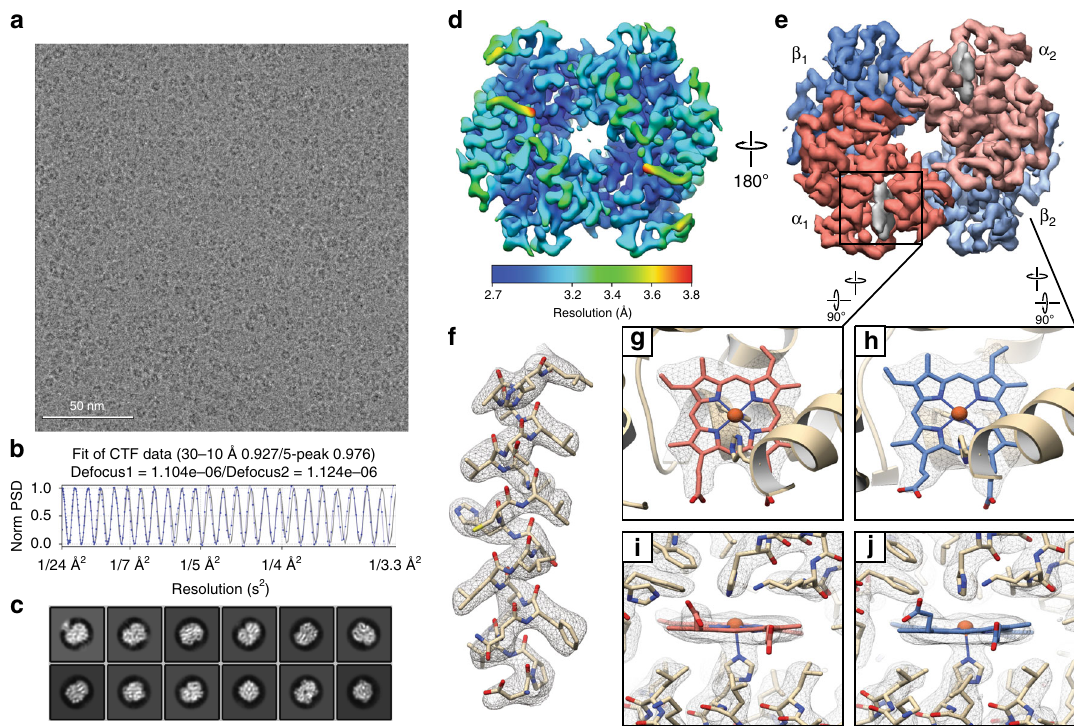
Fig. 2 2.8 Å resolution cryo-EM reconstruction of ~64 kDa human methemoglobin. a Representative motion-corrected electron micrograph of human methemoglobin (metHb) embedded in vitreous ice recorded at ~1.1 µ m defocus (scale bar, 50 nm). b 1-dimensional plot of the contrast transfer function (CTF) Thon rings (black line) and the CTF estimated with CTFFIND4 33 (blue line). c Representative reference-free 2D class averages showing secondary structure elements. d , e Final ~2.8 Å resolution metHb cryo-EM density colored by local resolution (estimated using BSOFT 23 ) and subunit with the segmented EM density for the heme cofactors colored gray, respectively. f EM density (gray mesh) zoned 2 Å around an α -helix comprising residues 94 – 113 from the α subunit. g – j EM density in the vicinity of the heme cofactors from subunit α 1 and β 2. Lower panels are 90° rotations of upper panels. Residues are shown in stick representation (colored wheat) and the heme cofactors are colored according to the subunit coloring in e . The heme iron atoms are shown as orange spheres